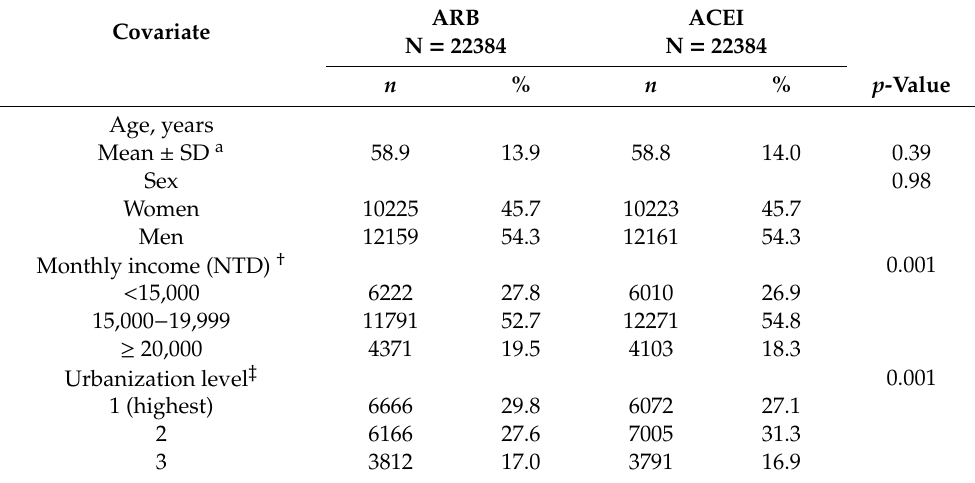
Table 1. Demographic characteristics and clinical comorbidity status in study cohorts by propensity score